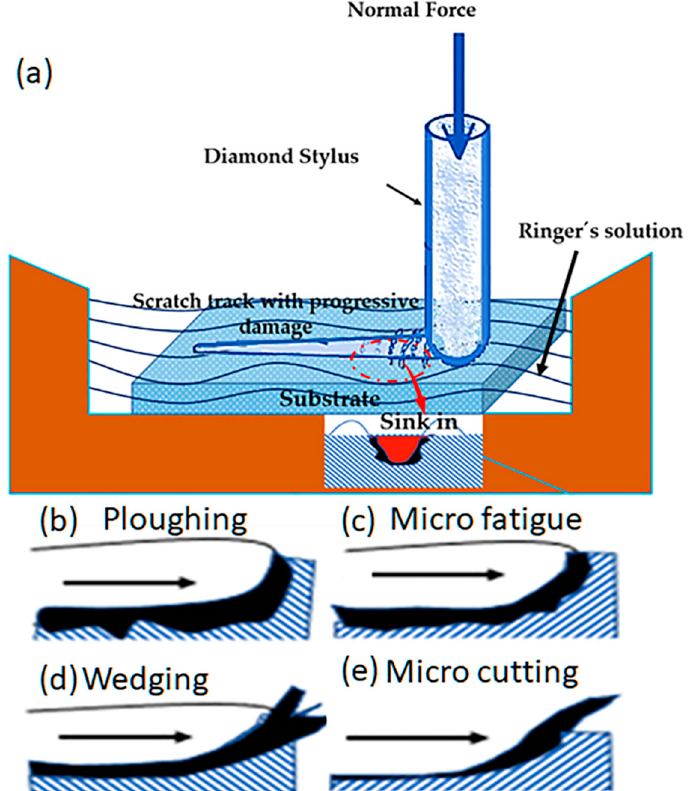
Figure 4. Determination of the scratch groove material removal factor (f ab ) by evaluating three positions along the length of the scratch.